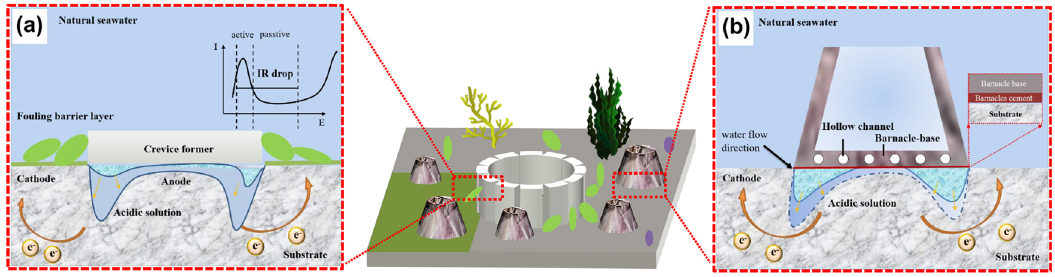
Fig. 12 Schematic diagram of crevice corrosion in natural seawater. a arti fi cial crevice, b barnacle-induced crevice